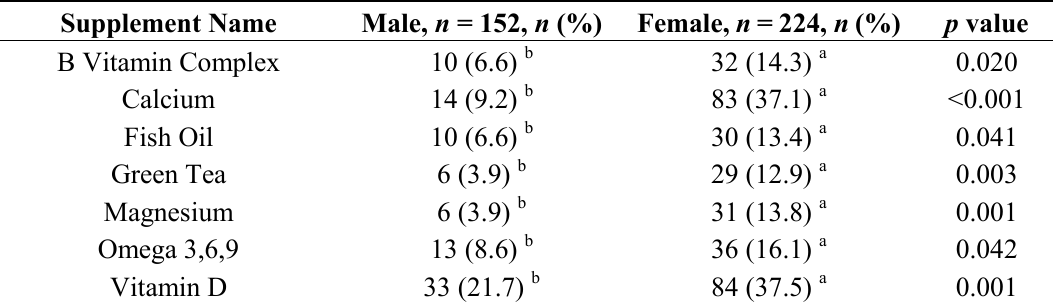
Table 4. Sex Differences in Supplements Used.